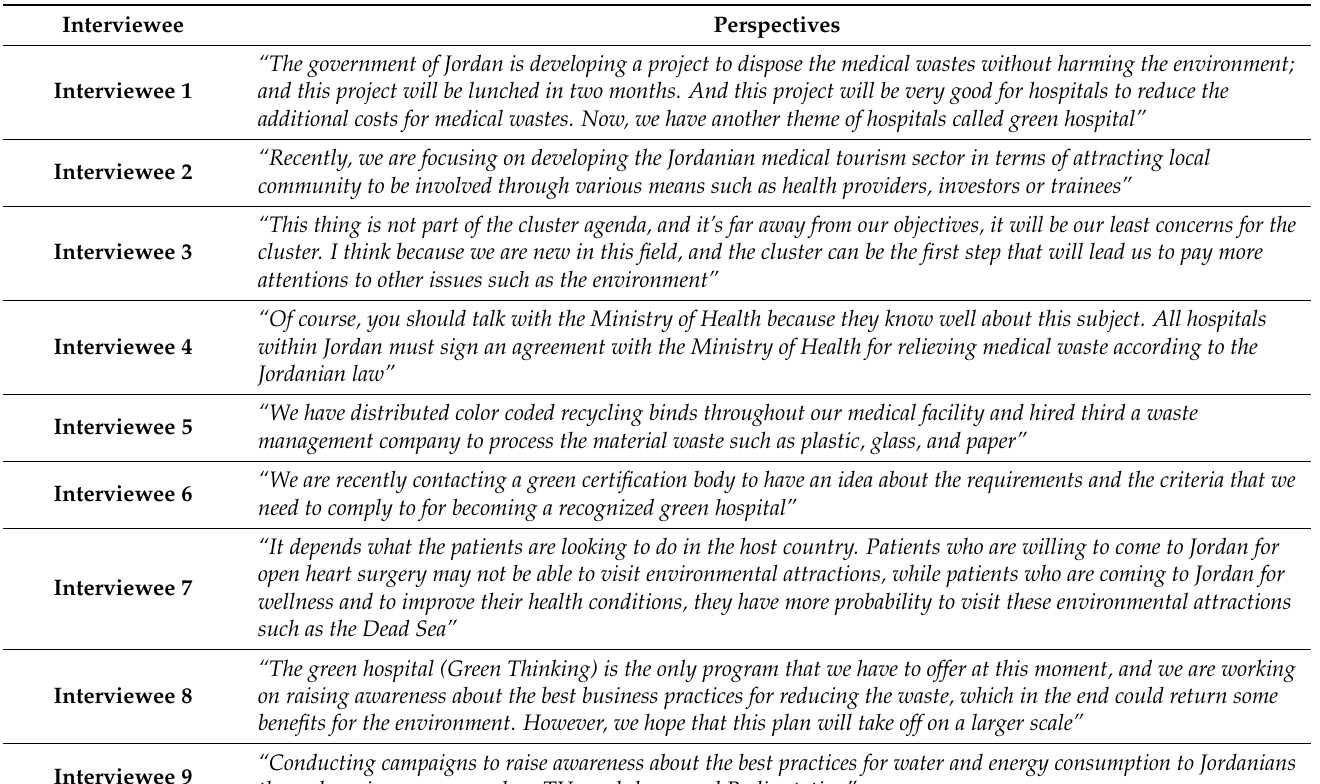
Table 5. How medical tourism projects or private medical facilities can be managed to protect the environment?